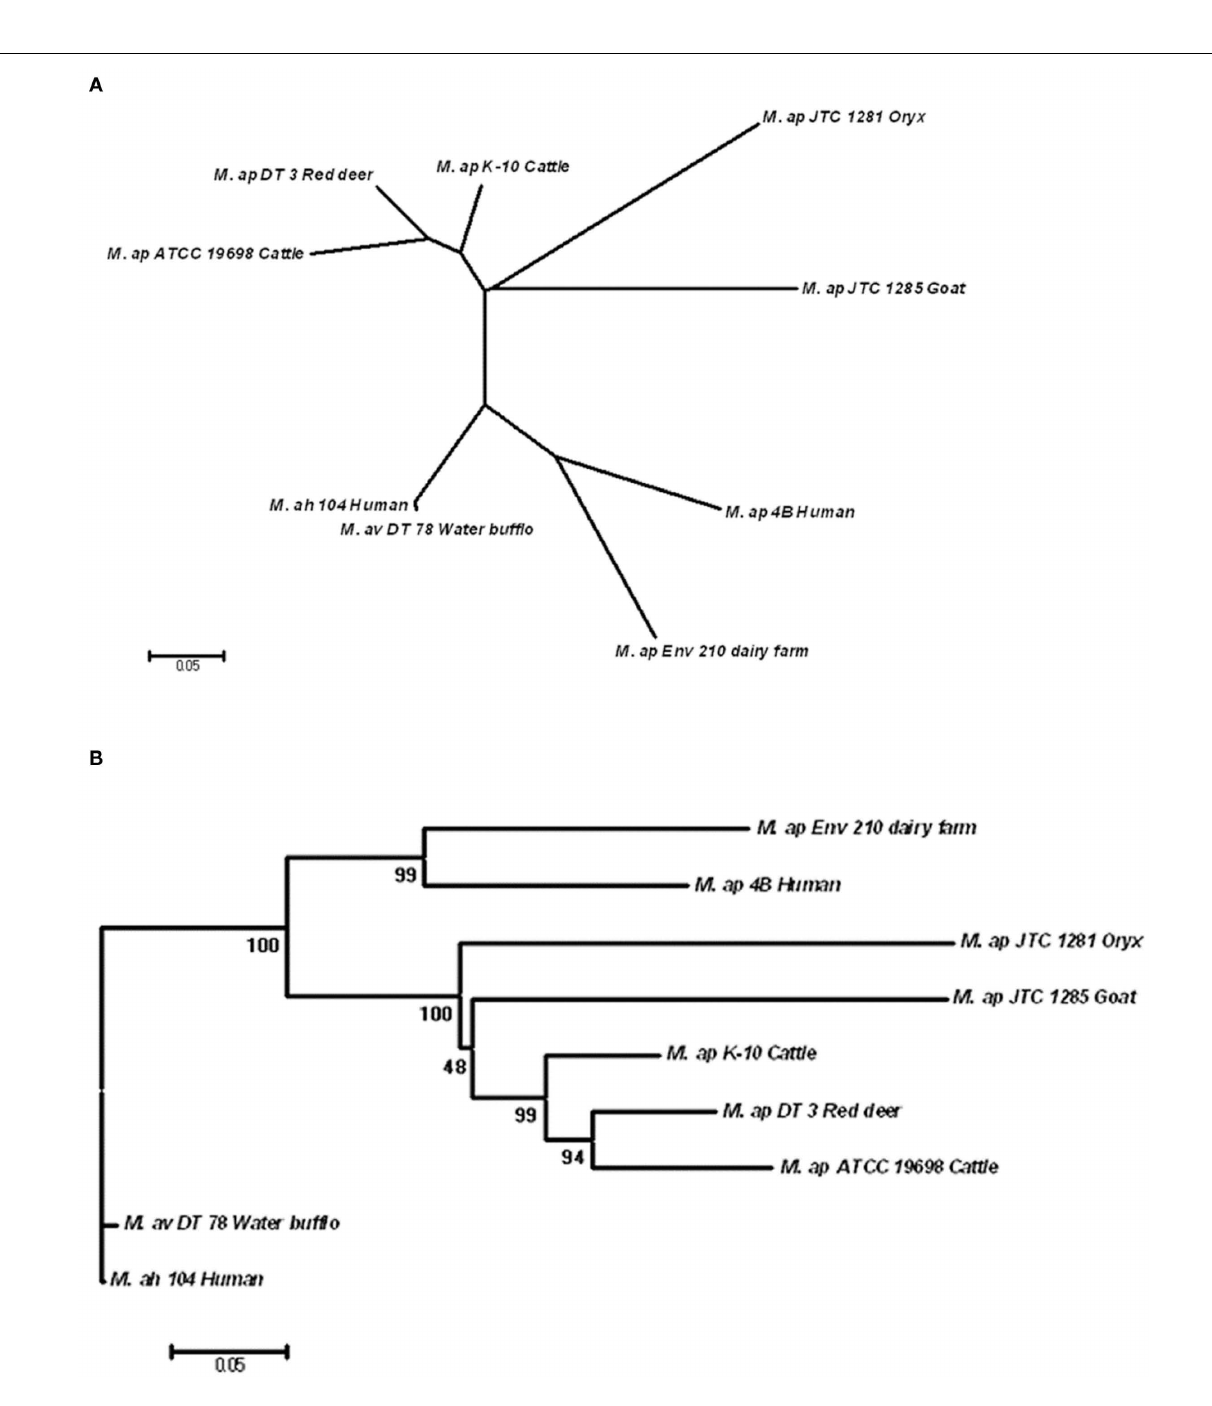
FIGURE 5 | Phylogenomic analysis of M. ap and M. avium strains. (A) A dendrogram displaying an un-rooted, Neighbor-joining tree of the concatenated SNPs from all eight mycobacterial isolates under study. (B) A rooted Neighbor-joining tree using M. ah 104 genome as out group.The bootstrap consensus tree inferred from 1,000 replicates is taken to